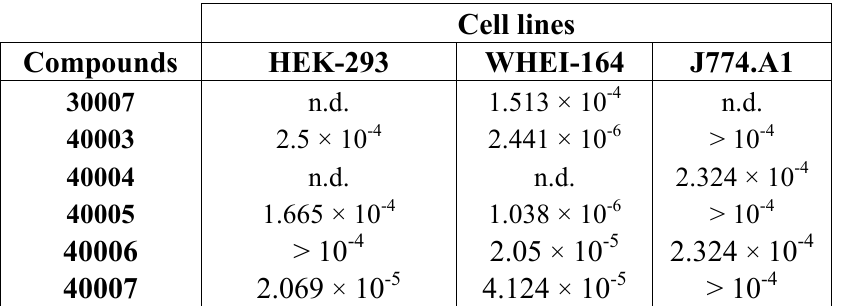
Table 2. Cont. Cell lines